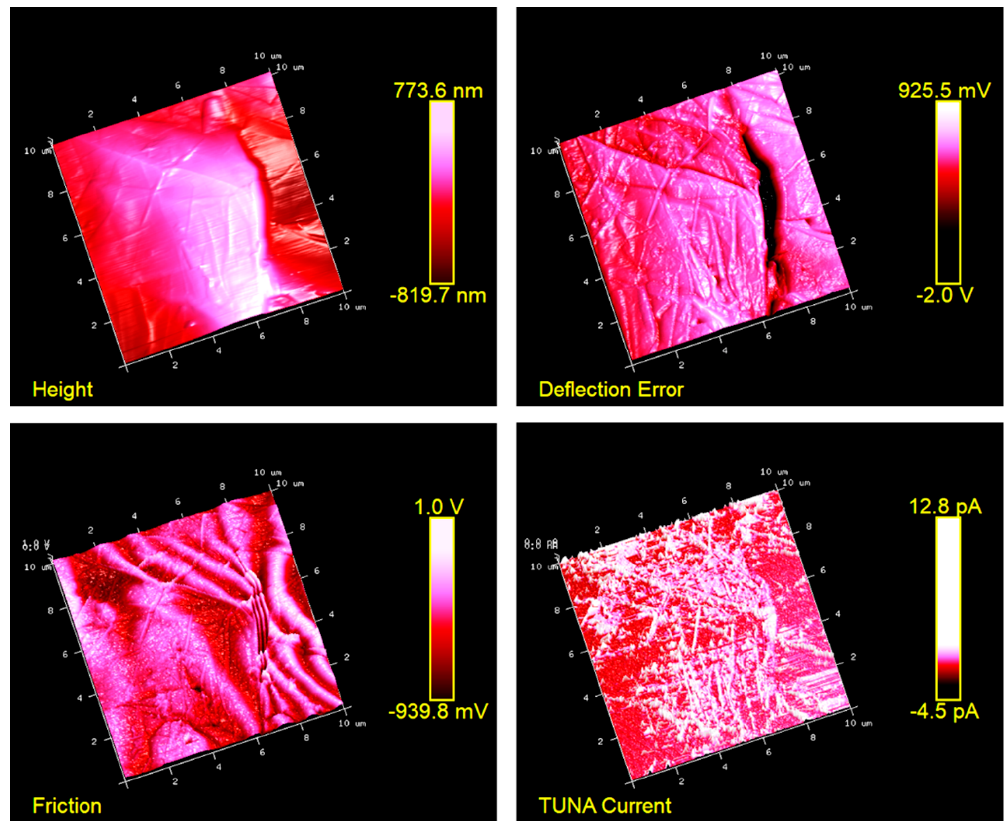
Figure 7. TUNA pictures of the R1%G-py fracture surface.